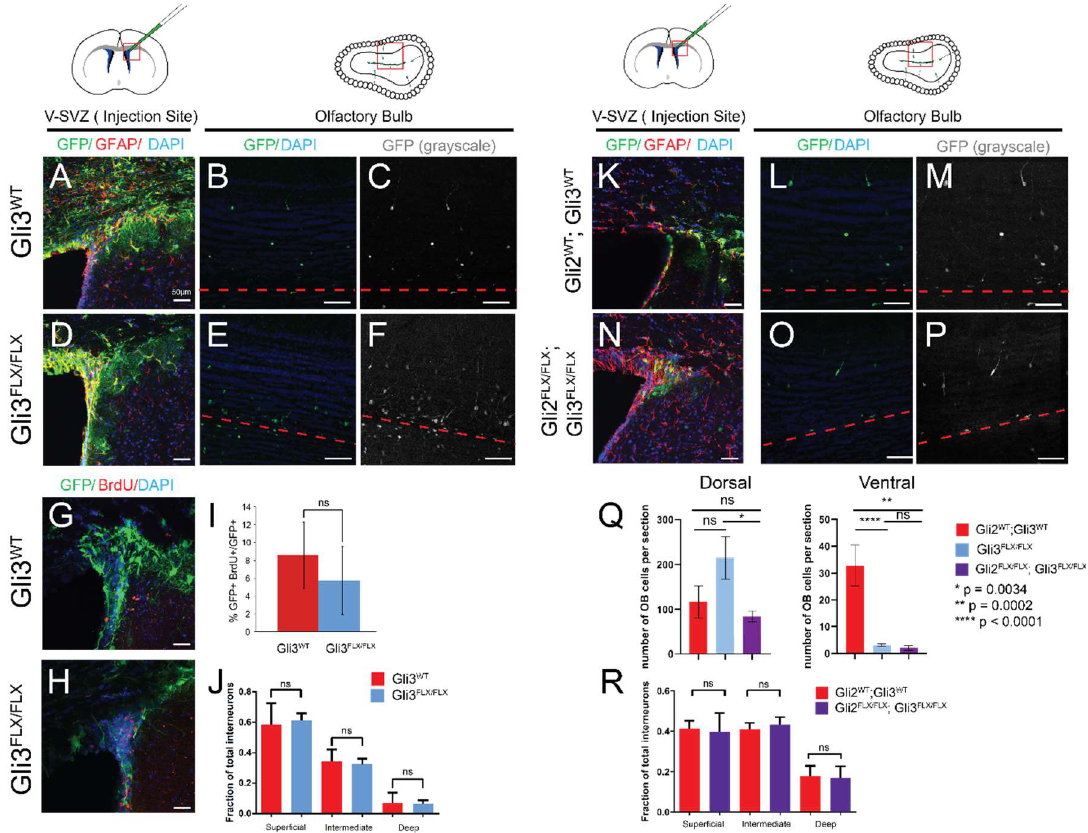
Figure 3. Removal of GLI3 or GLI2/GLI3 does not alter olfactory interneuron production in the dorsal V-SVZ: Ad-GFAPp-Cre virus was injected in dorsal V-SVZ in CAG , Gli3 FLX/FLX ; CAG , or Gli2 FLX/FLX ; Gli3 FLX/FLX ; CAG animals, and brain tissue was analyzed 30 days after injection. Approximate locations of the imaged areas are indicated by red boxes. GFP/GFAP double-labeled cells were found at the injection site ( A , D , K , N ), and GFP-labeled progeny were scored in the olfactory bulb for all sites and genotypes ( B , E , L , O ; GFP alone shown in C , F , M , P ). Scale bars—50 microns; red dashed lines indicate the core of the olfactory bulb. Ablation of GLI3 in the dorsal V-SVZ did not alter the fraction of GFP-positive cells that also incorporated BrdU ( G – I ). No difference in the location of interneurons in the granular layer was seen for any genotype ( J , R ). Ventral injection in either Gli3 FLX/FLX ; CAG animals or Gli2 FLX/FLX ; Gli3 FLX/FLX ; CAG animals resulted in a substantial reduction in the number of interneurons per tissue slice in the olfactory bulb; this was not seen after dorsal injections ( Q ).